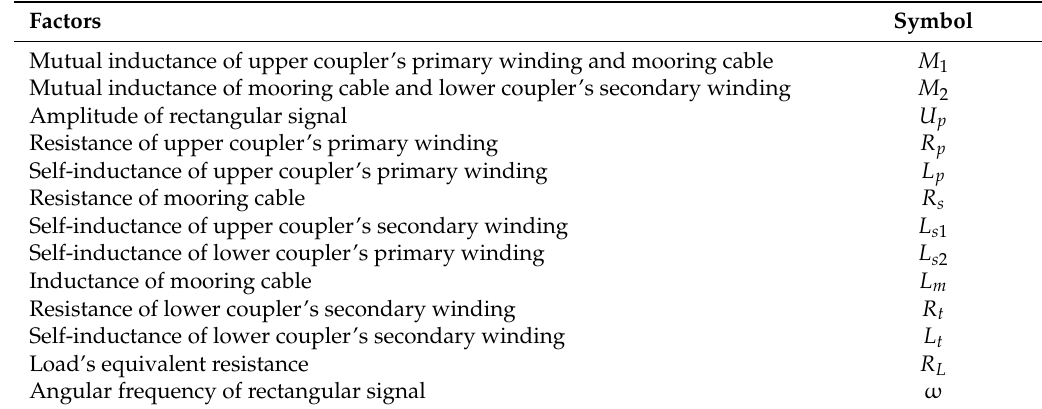
Table 1. Configuration